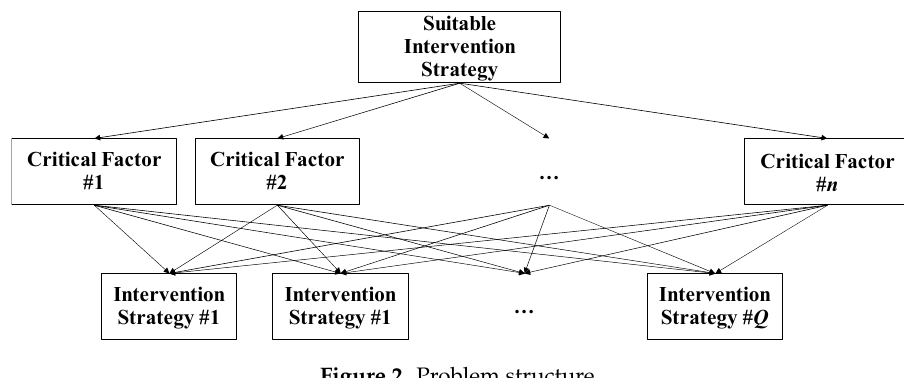
Figure 2. Problem structure.